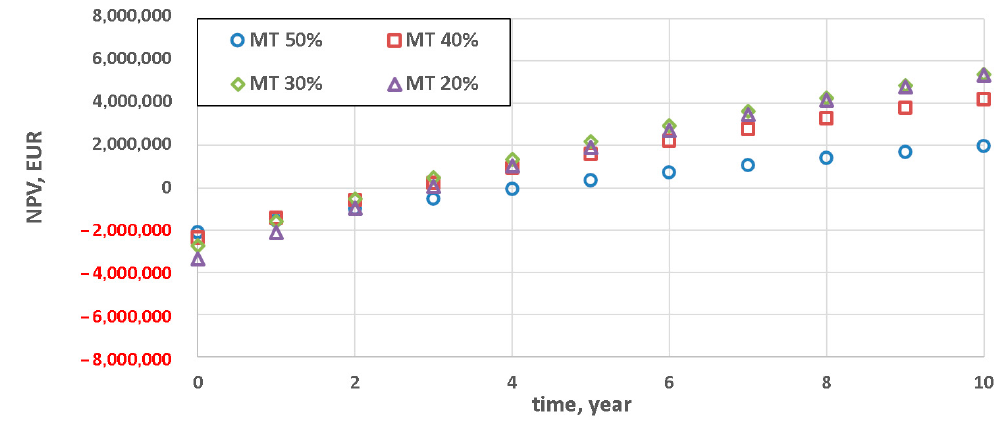
Figure 3. Results of Net Present Value analysis for different variants of achievable power unit technical minimum (MT) at coefficient Y = 0 (identical power of plasma torches assumed for all technical minimum levels).